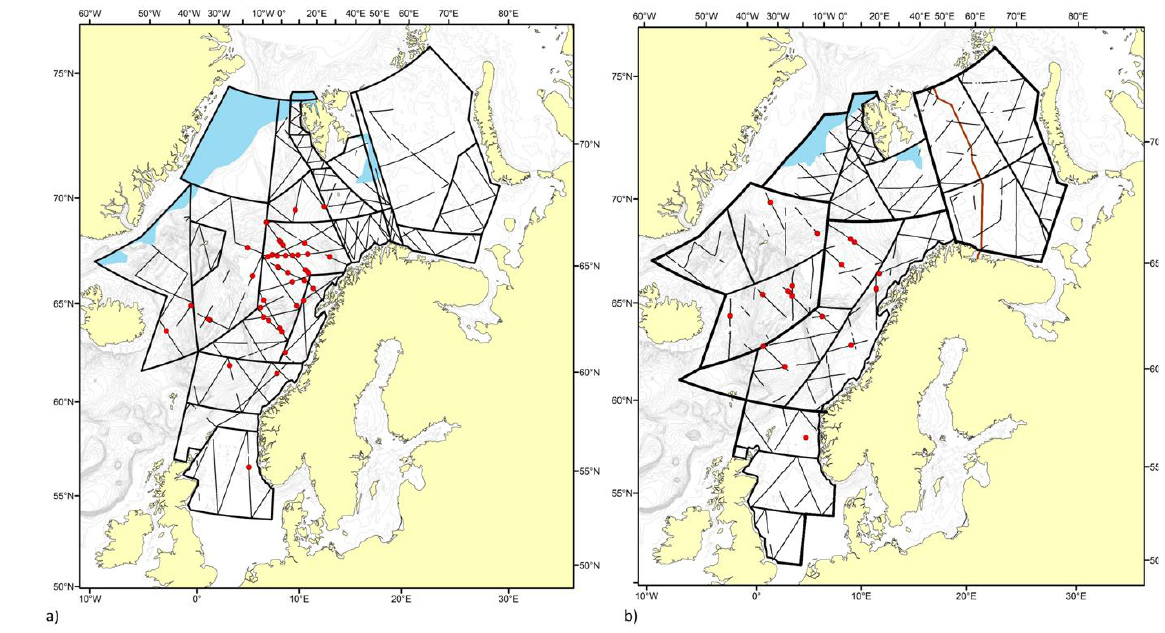
Figure 8. Distributions of sightings recorded as killer whales during (a) the 2002 – 2007 surveys and (b) the 2008 – 2013 surveys. The blue areas represent ice coverage.